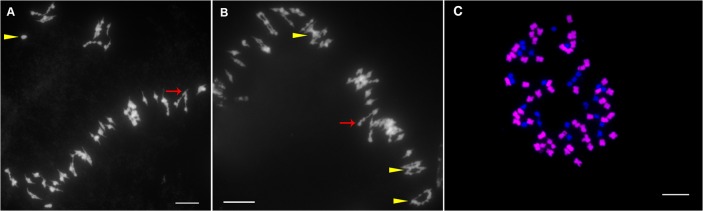
The amphiploids obtained by doubling chromosome complements in interspecific F1 hybrids between G. hirsutum and G. arboreum were confirmed by observation on chromosome configuration at metaphase I of meiosis in pollen mother cells and GISH on somatic cells.A, Univalent, bivalents and trivalent. Arrowhead (yellow) and arrow (red) indicate the univalent and trivalent, respectively. B, Bivalents, quadrivalents and pentavalent. Arrowhead (yellow) and arrow (red) indicate the quadrivalent and pentavalent, respectively. C, Red signals indicate the 52 chromosomes of A subgenome of G. hirsutum and G. arboreum and blue signals indicate the 26 chromosomes of D subgenome of G. hirsutum (stained with DAPI). The results demonstrate that the amphiploid is hexaploid and its genome component is 2n = 6x = AAAADD = 78. Scale bars, 10 μm.